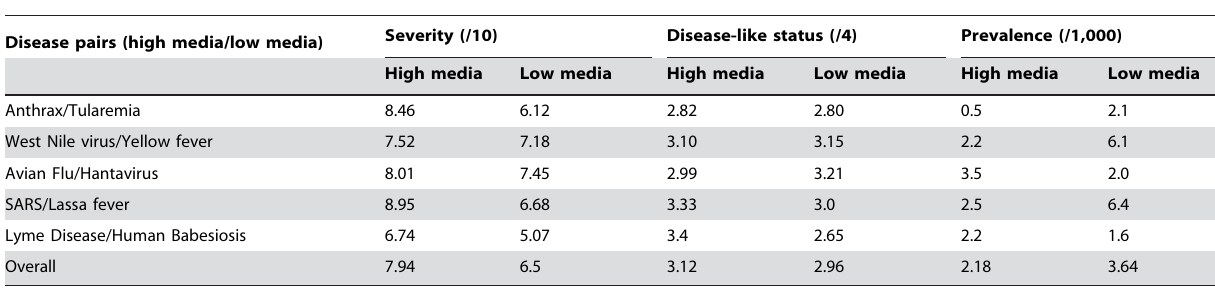
Table 4. Means for Each Infectious Disease: Experiment 2.